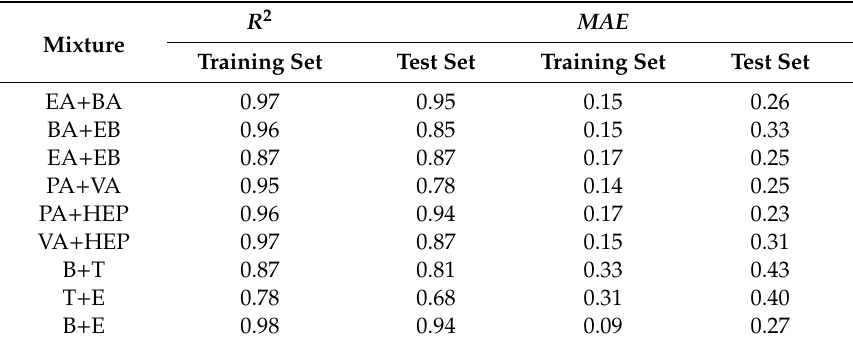
Table 2. The prediction accuracy of SVR models. The coe ffi cient of determination ( R 2 ) and mean absolute error ( MAE ) were individually calculated for each kind of binary